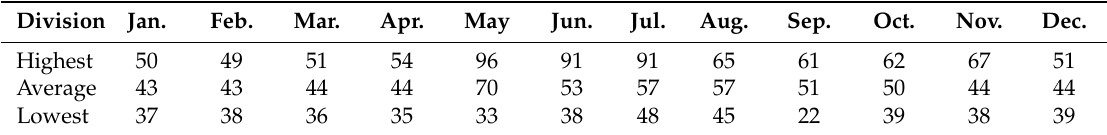
Table 2. First heated return temperature (unit: ◦